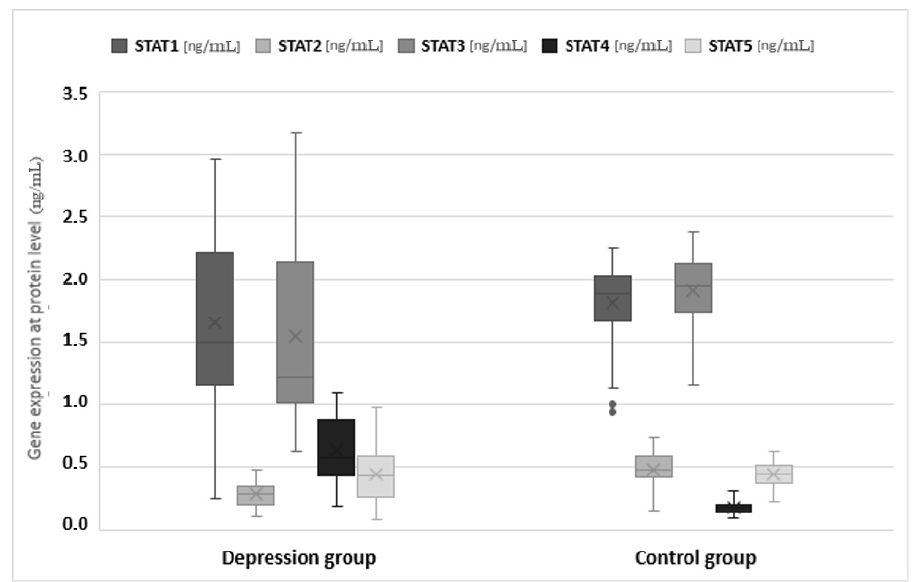
Figure 4. Expression of signal transducer and activator of transcription (STAT) protein family genes at the mRNA level in the depression and healthy control group. Statistical significance of differences in study groups: STAT1 p = 0.0120; STAT2 p < 0.0001; STAT3 p < 0.0001; STAT4 p < 0.0001; STAT5 p = 0.6931.